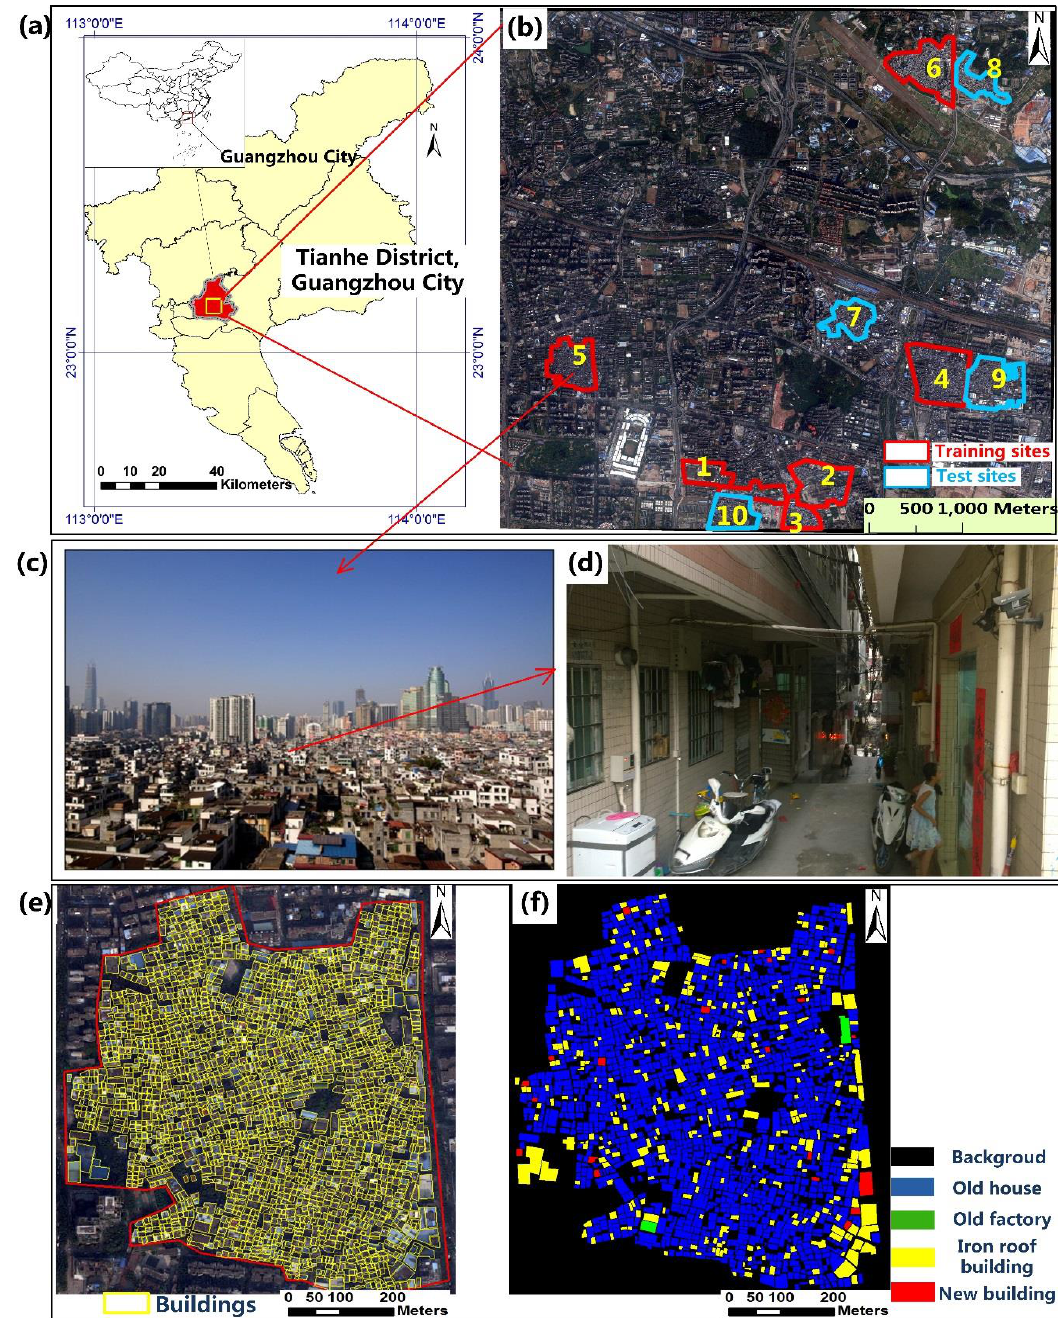
Figure 1. ( a ) Location of the study area in Tianhe District of Guangzhou City; ( b ) WorldView-2 image with red and blue polygons marked as training and test sites, respectively; ( c , d ) on-site view of one selected site; ( e ) vector file of the building boundaries; and ( f ) labeled image with building categories.